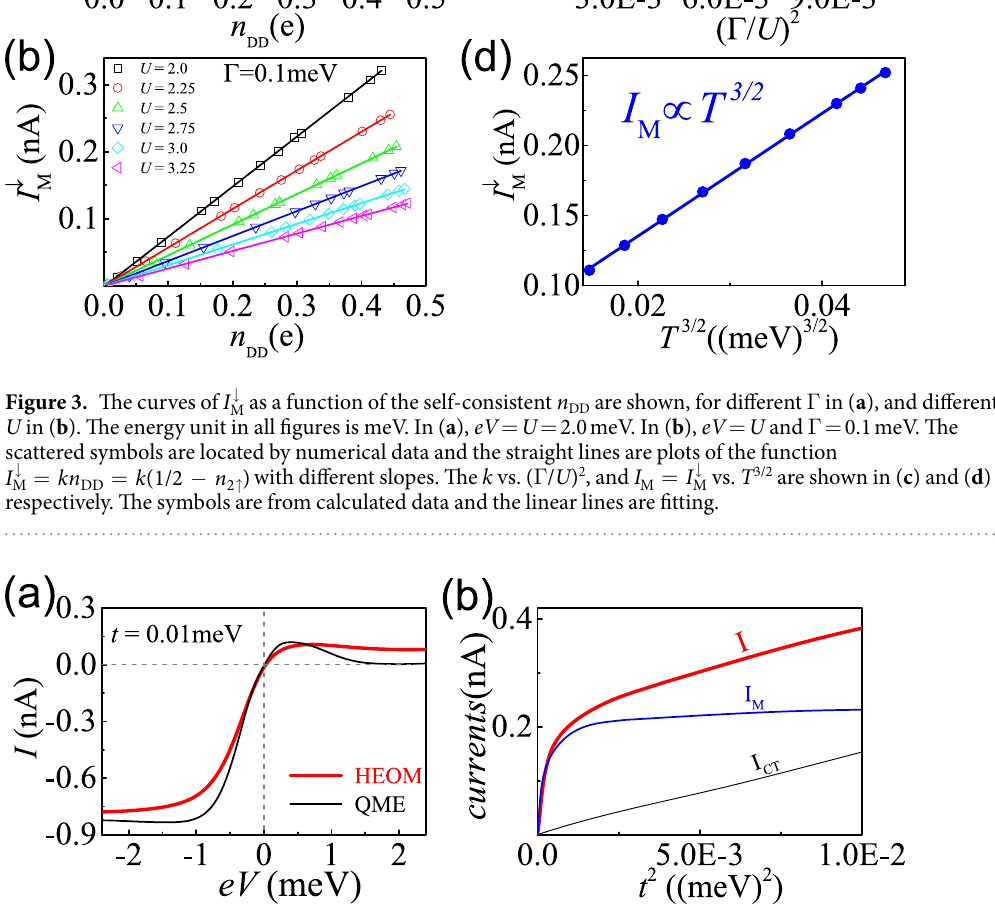
Figure 4. ( a ) The spin–degenerate counterparts to Fig. 2(a). ( b ) The spin–degenerate counterparts to Fig.